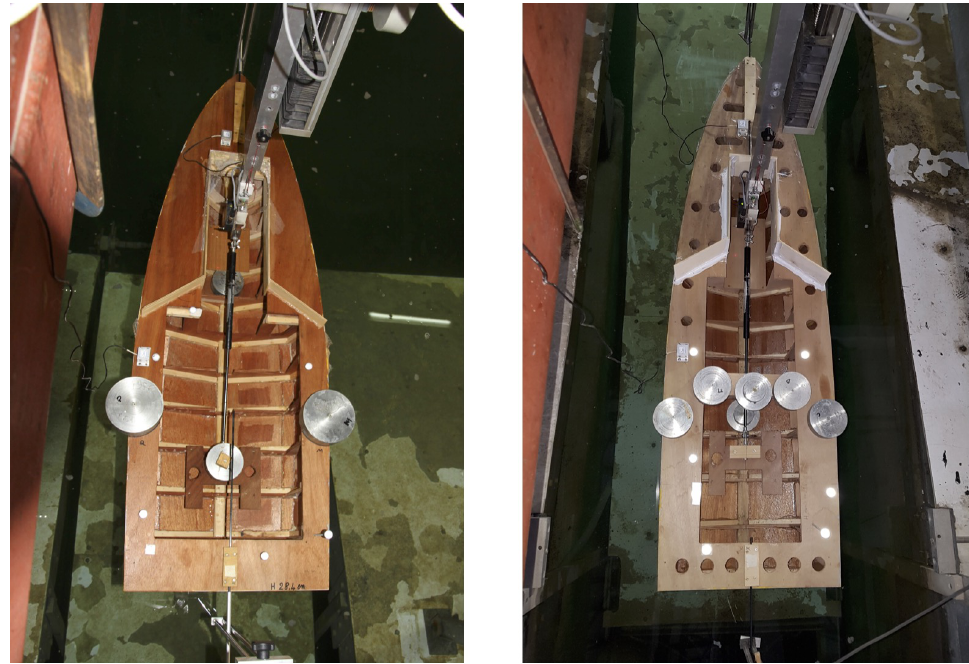
Figure 4. Top view of C1s ( left ) and C2s ( right )